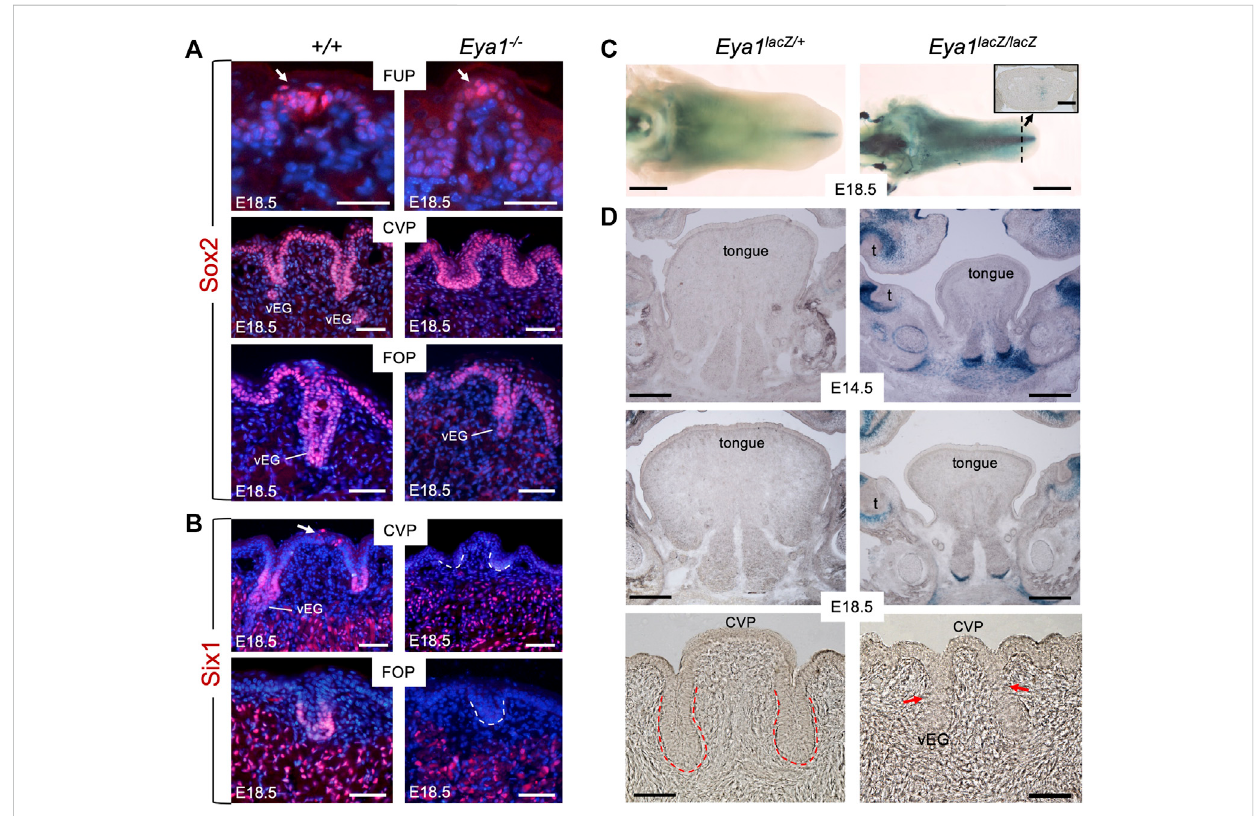
FIGURE 2 Loss of Six1 expression in CVP and FOP in Eya1- de fi cient tongues and absence of Eya1 expression in embryonic tongues. (A) Immunostaining on frontal sections showing Sox2 expression in E18.5 wild-type and Eya1 − / − FUP, CVP and FOP regions. Arrows indicate well-developed taste buds with clustered cells in wild-type FUP but not in Eya1 − / − . (B) Immunostaining on frontal sections showing Six1 expression in CVP epithelium (arrow) and trenches,FOPtrenches,vonEbner ’ sglandandmusclecellsinE18.5wild-type,butitsexpressioninthepapillaandtrenchepitheliumislostin Eya1 − / − . (C) Whole-mount X-Gal staining of Eya1 LacZ/+ and Eya1 LacZ/LacZ tongues at E18.5. (D) Frontal sections showing X-Gal staining of Eya1 LacZ/+ and Eya1 LacZ/LacZ tongues at E14.5 and E18.5. Red arrows point to the end of the trench epithelium, which was followed by a cluster of epithelial cells. Abb.: t, tooth; vEG, von Ebner ’ s gland. Scale bars: 30 μ m (for top panels of FUP in A), 50 μ m (for CVP and FOP in A,B), 1 mm (C) and 300 μ m (D)